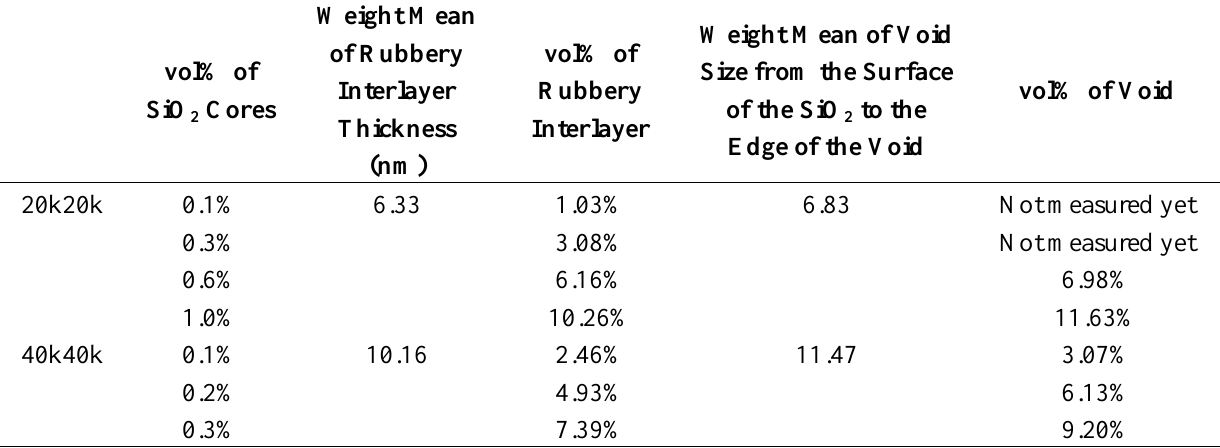
Table 6. Weighted mean of rubbery interlayer size and void size in both 20k20k and 40k40k